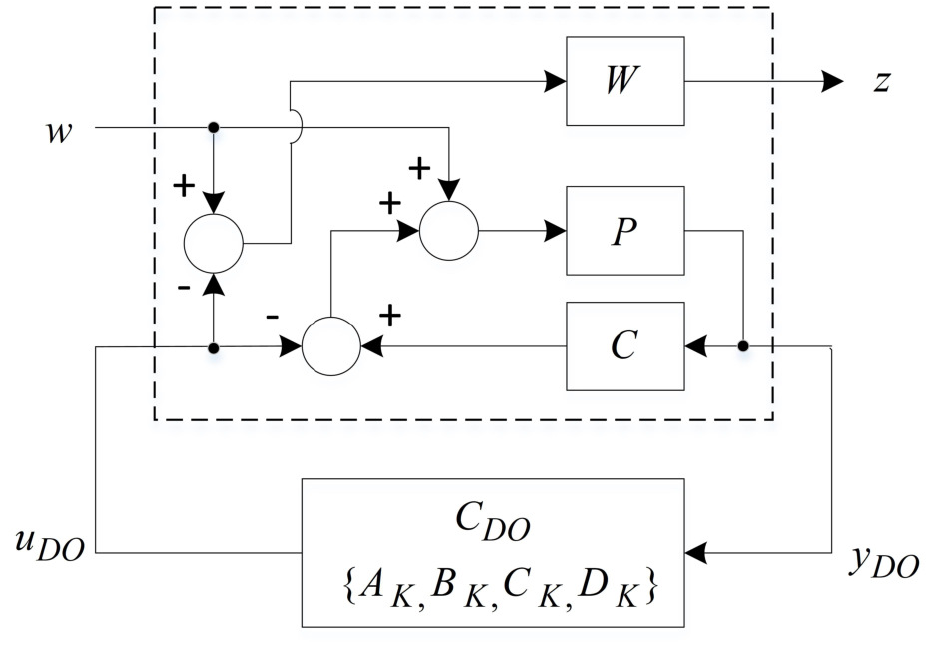
Figure 2. Proposed framework for optimal DO